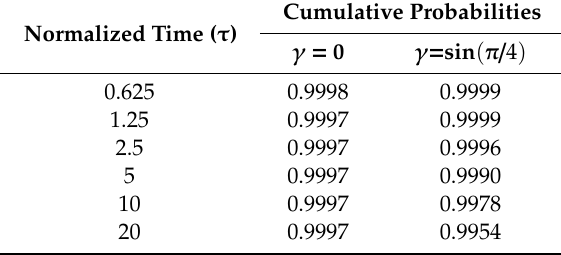
Table 1. The numerically calculated cumulative probabilities at various normalized time, for γ = 0 and γ = sin ( π /4 )